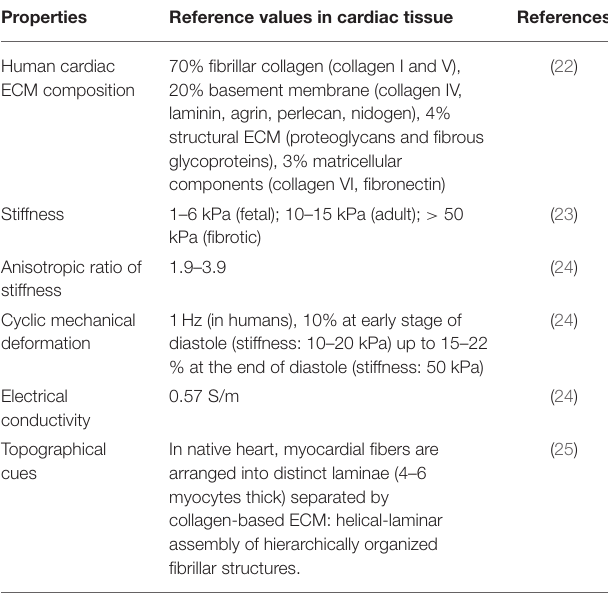
TABLE 1 | Reference cardiac tissue-like properties for biomimetic culture